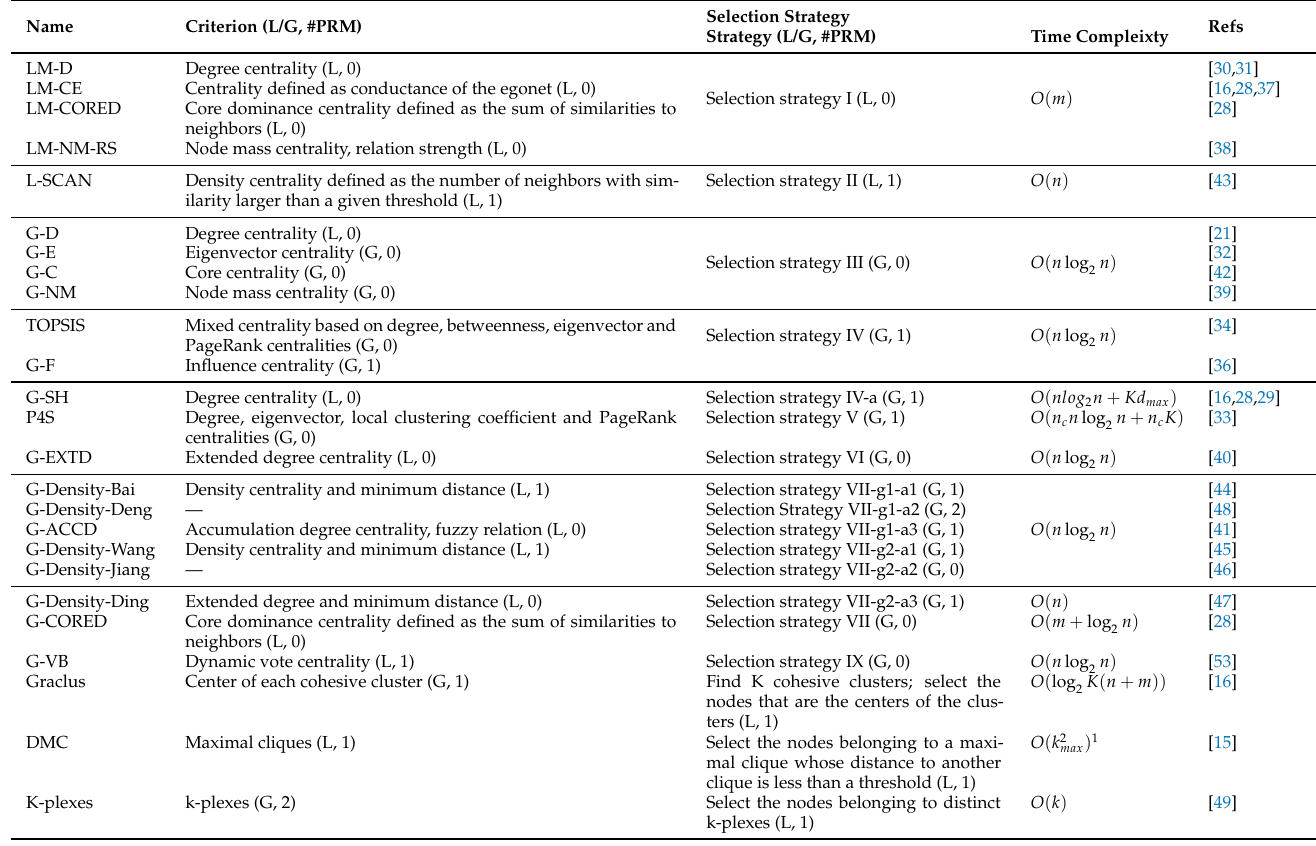
Table 1. Summary of seeding algorithms. “L” represents that the criterion or selection strategy is local, and “G” represents that it is global, and “#PRM” represents the number of